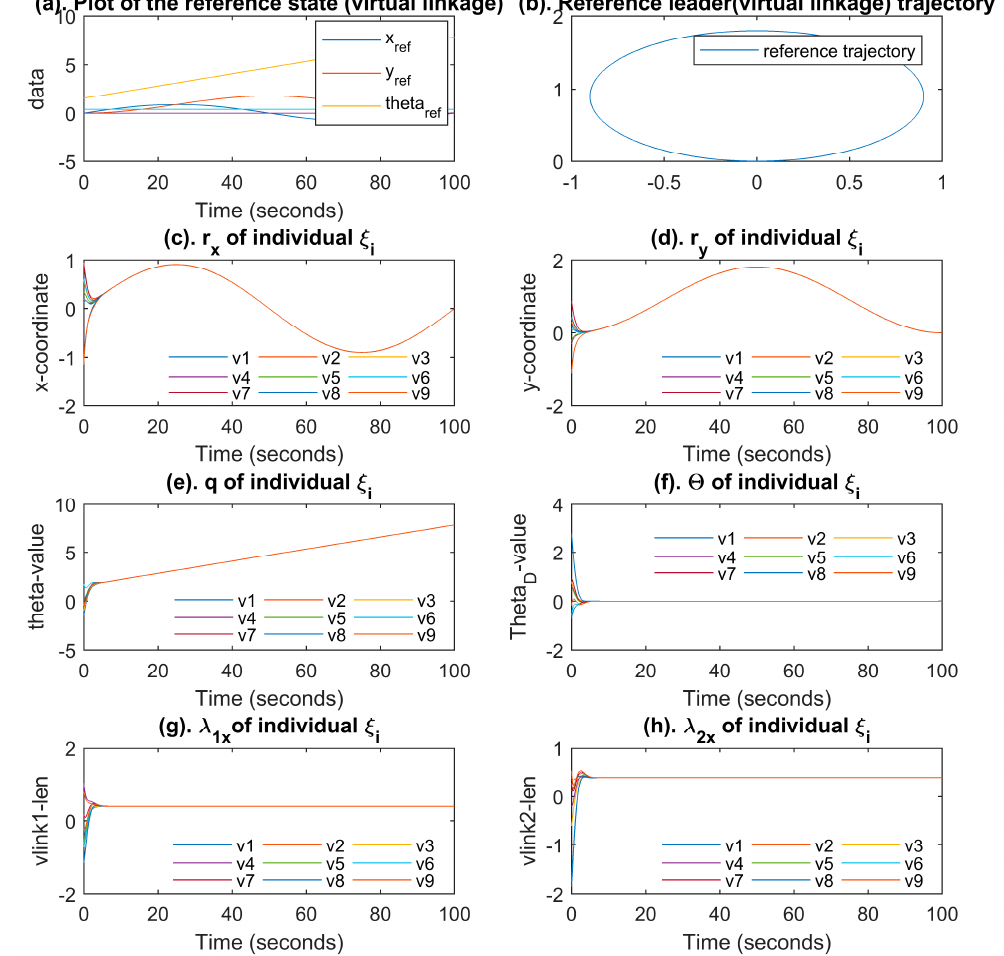
Figure 9. Simulation results of nine agents move around a circle in line formation.